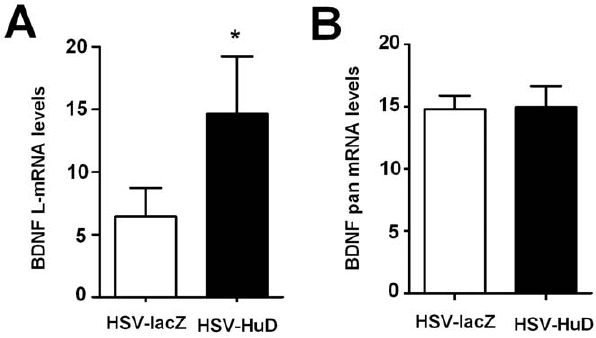
Figure 5. Forced expression of exogenous HuD selectively enhanced expression of BDNF long 3 9 UTR mRNA in primary cultured neurons. E17 cortical neurons were cultured for 2 days and then infected with HSV-HuD or HSV-lacZ virus. Following 3 days in culture, the levels of long 3 9 UTR BDNF mRNA and pan BDNF mRNA were determined by qRT-PCR using primers specific in the long 3 9 UTR (A) and primers in the coding region that detects the pan BDNF mRNA (B). *p , 0.05 (Student’s t-test,